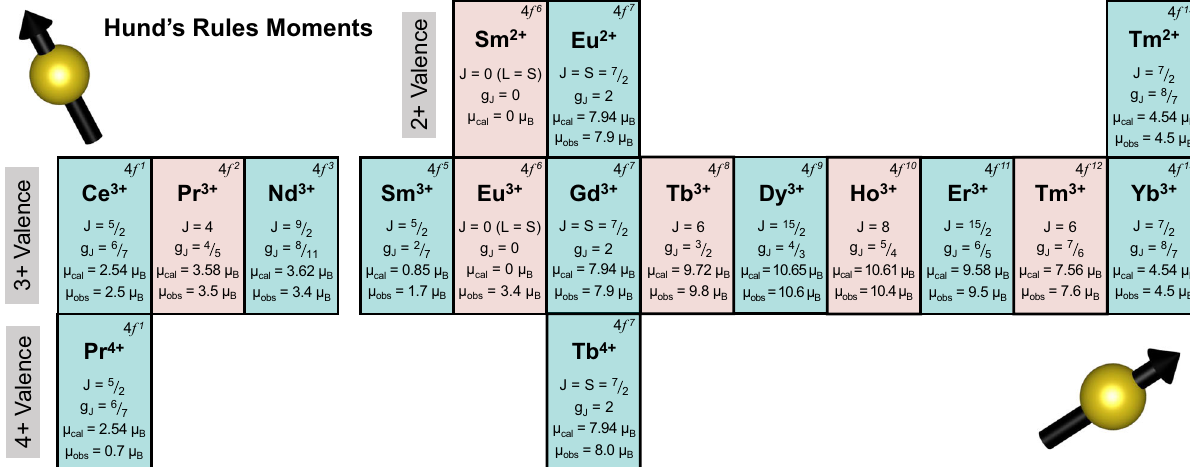
Fig. 4 Schematic illustration of the magnetic properties of rare earth ions. Magnetic properties of rare earth ions in their divalent (top row), trivalent (middle row) and tetravalent (bottom row) states arranged according to their number of f electrons. Each entry includes the Hund ’ s rules total angular ffiffiffiffiffiffiffiffiffiffiffiffiffiffiffi p momentum J , the Landé g-factor g J , the calculated paramagnetic moment μ cal ¼ g J J ð J þ 1 Þ , and the experimentally observed paramagnetic moment μ eff . Excellent agreement between the calculated and observed moments is found for almost all rare earths. Poor agreement for Sm 3 + , Eu 3 + , and Pr 4 + is due to the proximity of the next highest spin – orbit manifold. The blue shaded ions have an odd number of electrons and therefore Kramers ions, which are guaranteed to have at least a ground state doublet while the pink shaded ions are non-Kramers ions, where a non-magnetic singlet ground state is allowed by symmetry. Non-magnetic Ce 4 + and Yb 2 + are not included